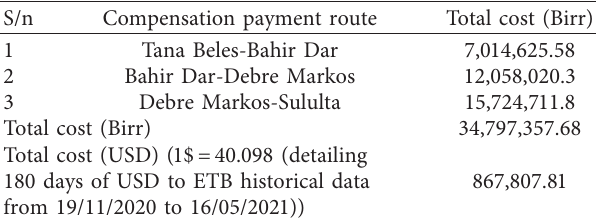
Table 4: Compensation cost required.